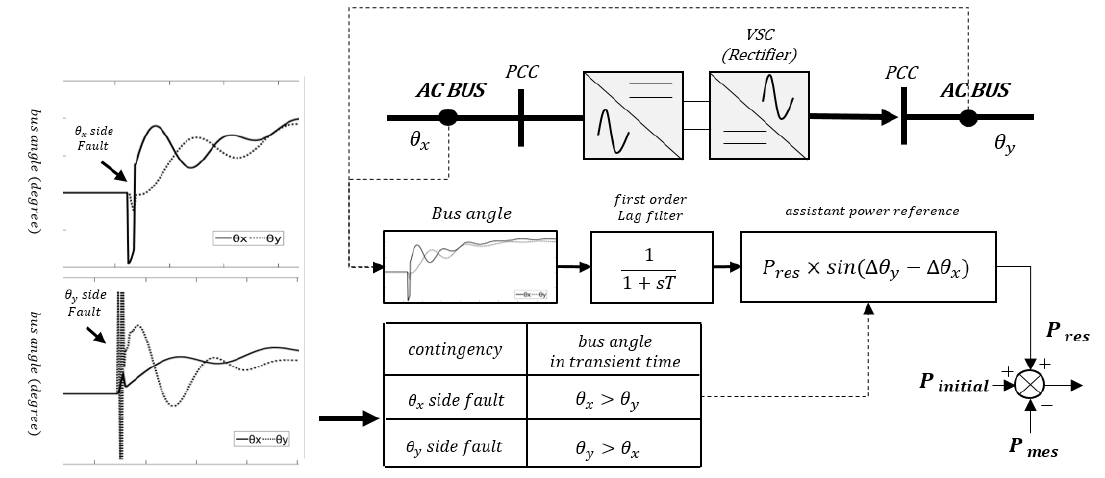
Figure 3. The first power control model structure of BTB.